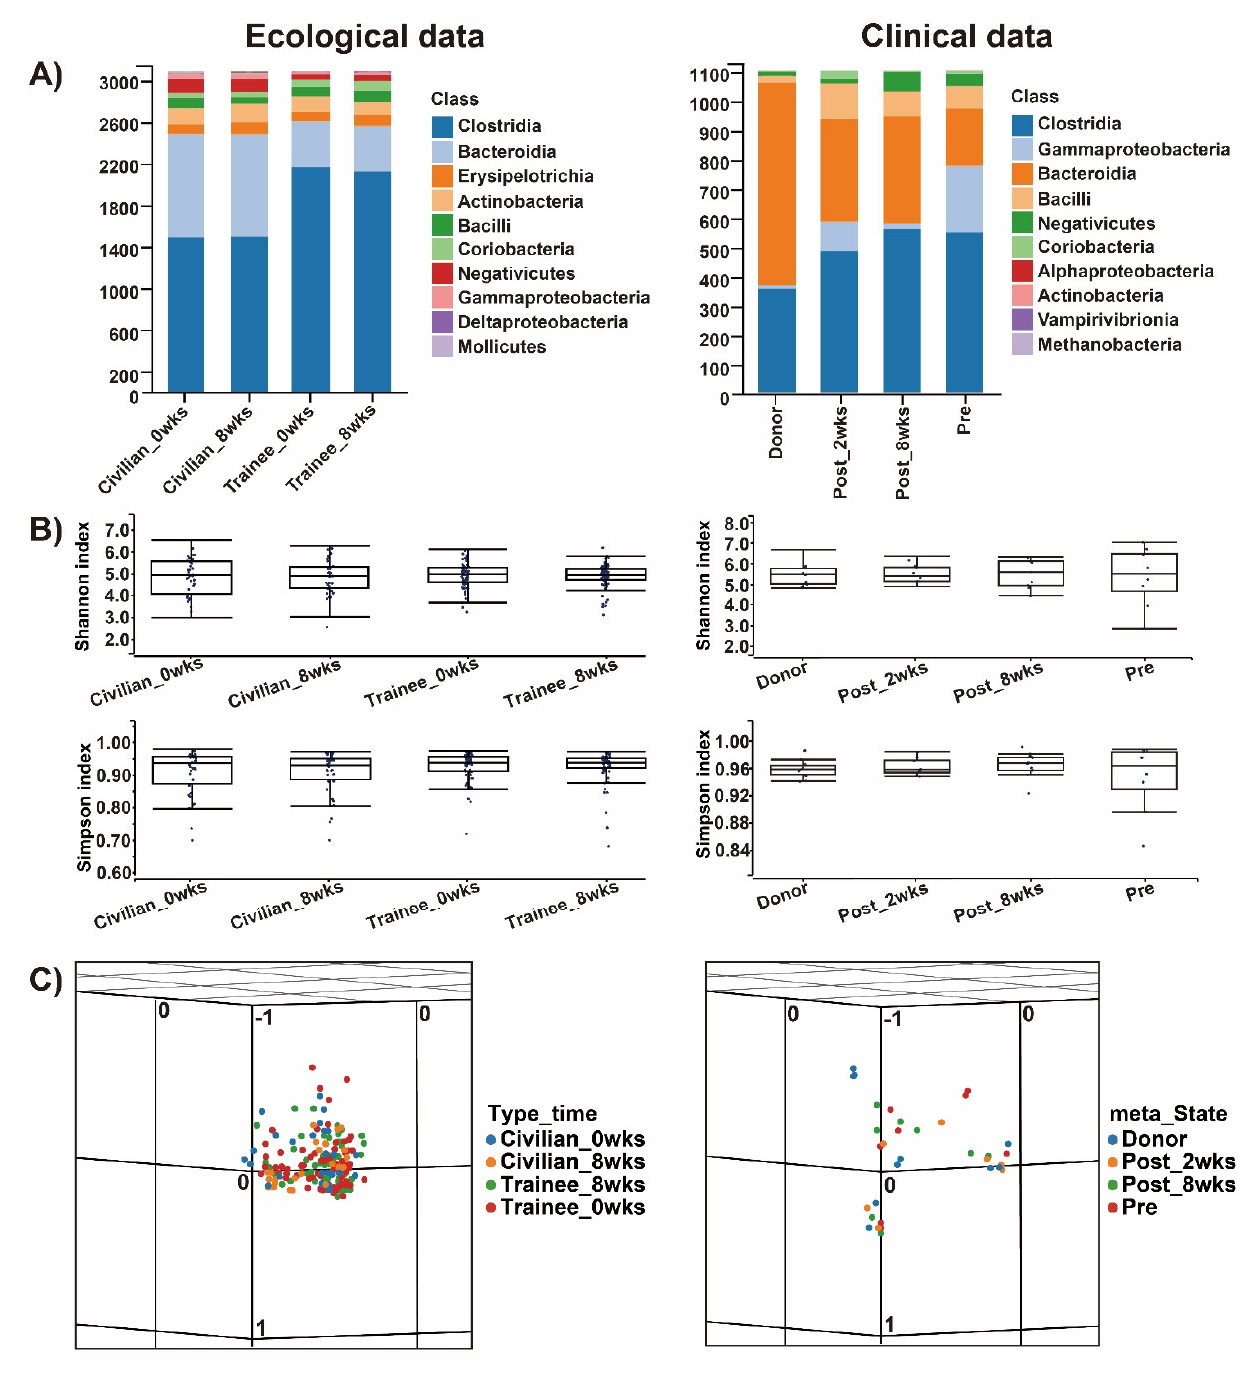
Figure 3. Output figures for ( A ) taxonomic data (class), ( B ), alpha diversity (Shannon, Chao1, and Simpson index), and ( C ) beta diversity (Bray − Curtis dissimilarity) based on different analysis approaches using ecological (left) and clinical (right) datasets in Mian.